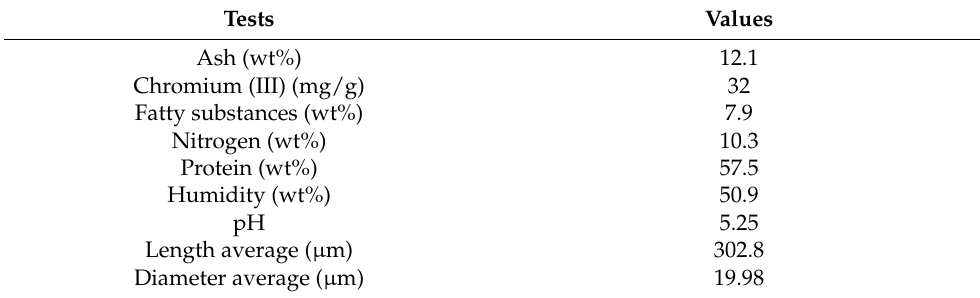
Table 1 [25]. HDPE Braskem 7252 was supplied by Nexeo Solutions (Sao Paulo, Brazil) and was used as thermoplastic matrix. Table 1. Characteristics of buffing dust